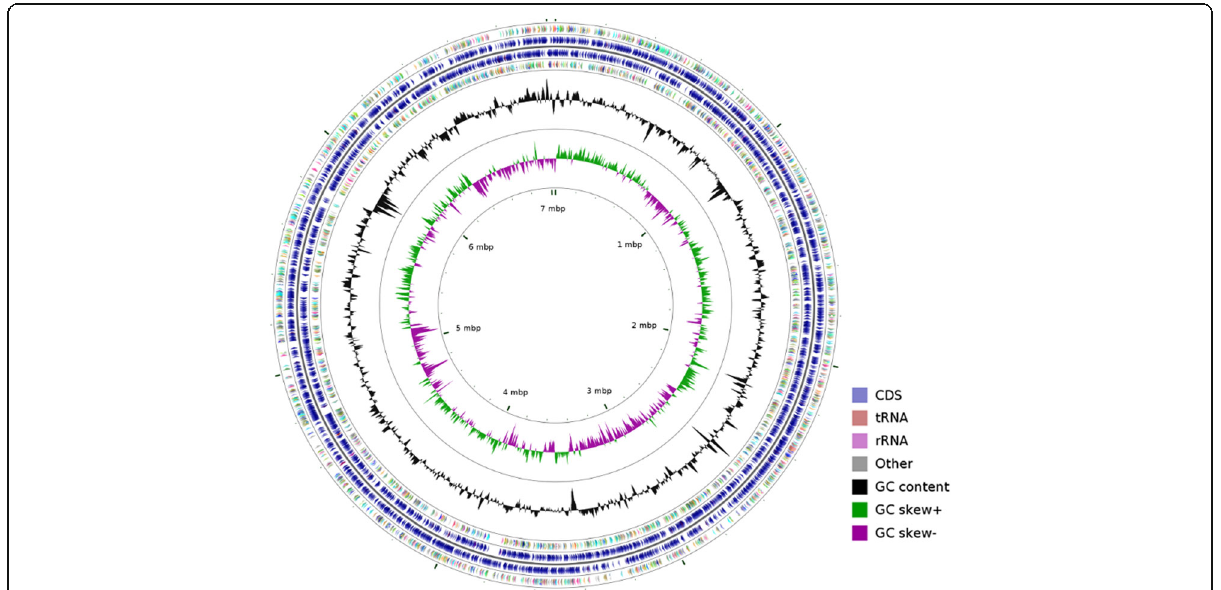
Fig. 5 A graphical circular map of Mucilaginibacter pedocola TBZ30 T . From outside to center, rings 1, 4 show protein-coding genes colored by COG categories on forward/reverse strand; rings 2, 3 denote genes on forward/reverse strand; rings 5 show G+C % content; ring 6 shows G+C % content plot and the innermost ring shows GC